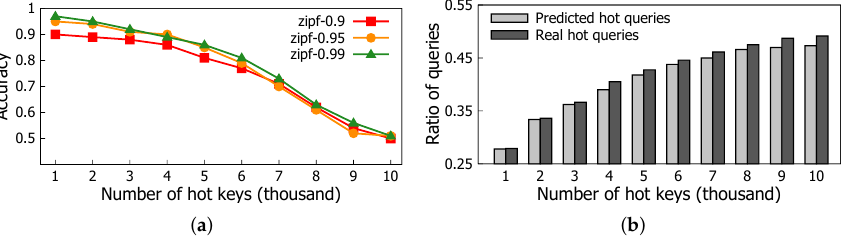
Figure 8. Accuracy of predicting popular keys. ( a ) Accuracy of finding K most popular keys; ( b ) Percentage of workload of hot